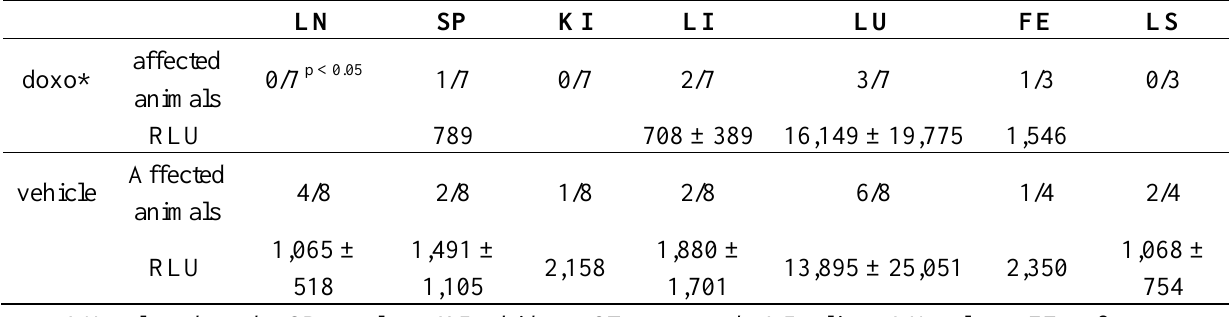
Table 2. Anti-metastatic effects of intravenous bolus doxorubicin application in the subcutaneous MAT-Lu